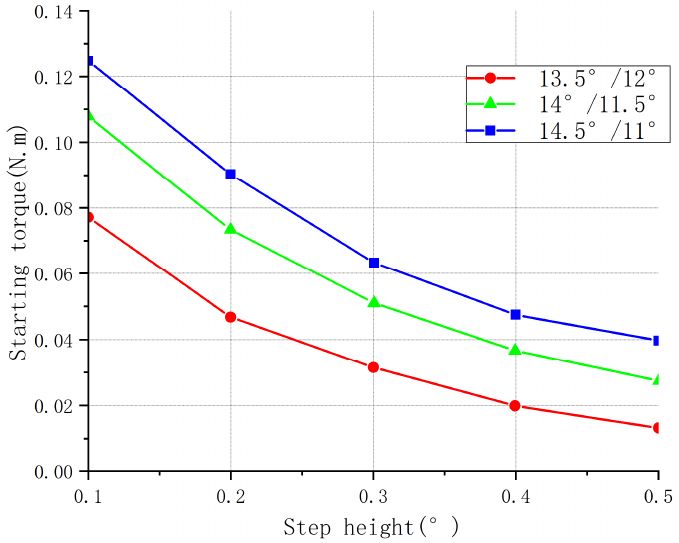
Figure 8. Starting torque of different step heights for three parameter combinations.